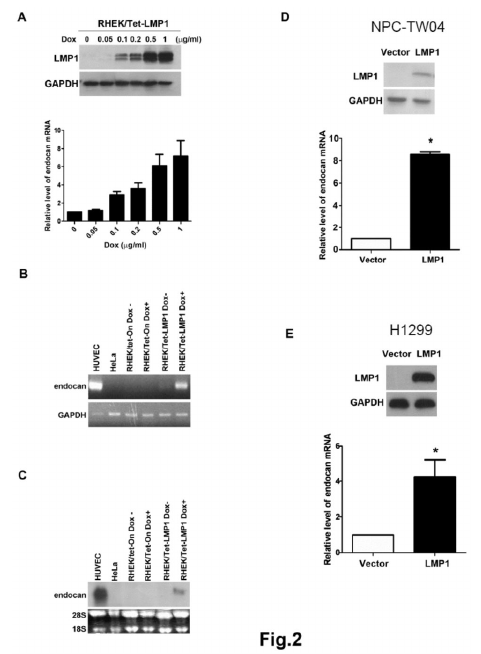
Figure 2. Induction of endocan expression by LMP1 in epithelial cell